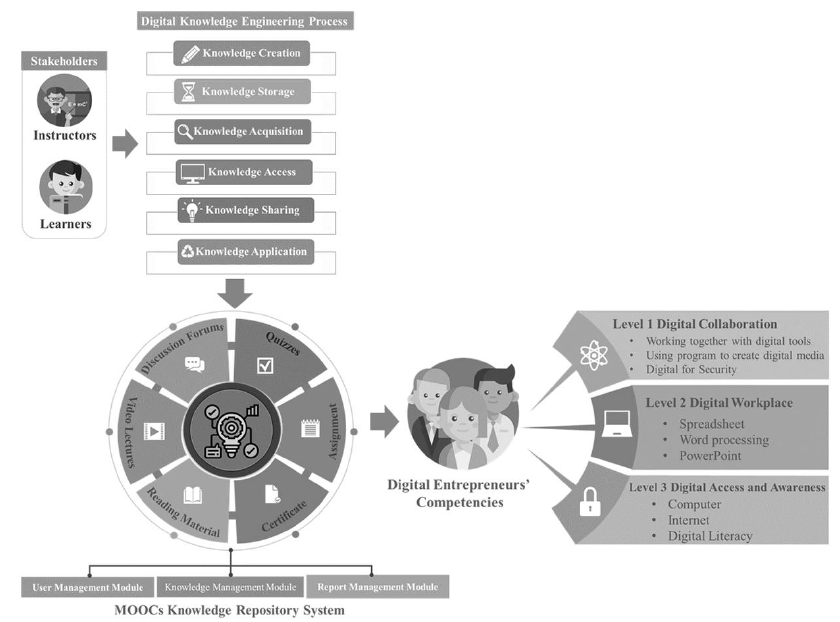
Fig. 3. Learning Ecosystem Using Digital Knowledge Engineering through MOOCs Knowledge Repository